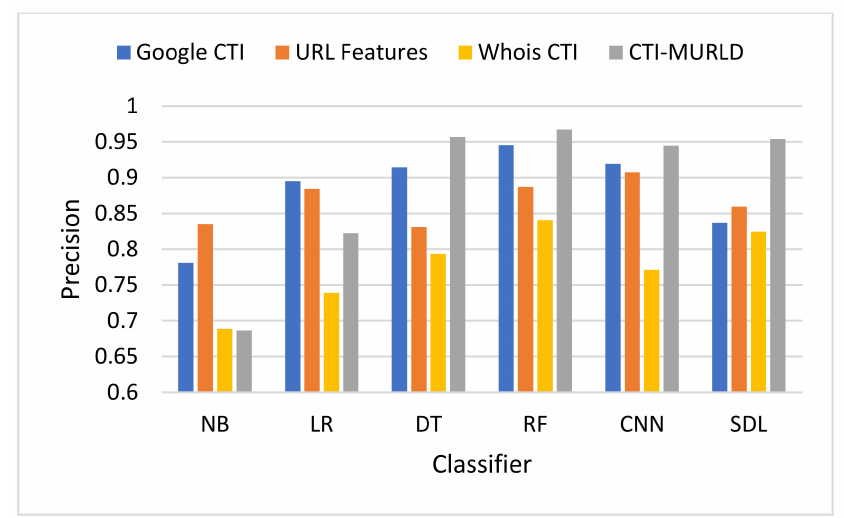
Figure 7. Comparison in terms of the precision.